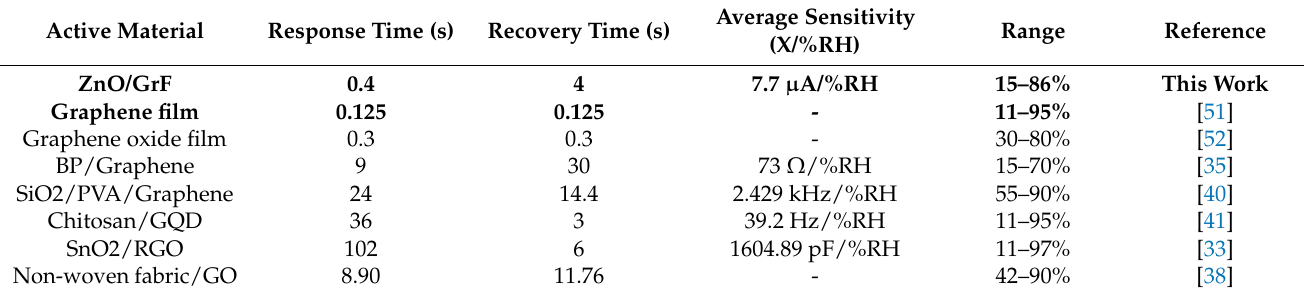
Table 4. General comparison of proposed work with different graphene composite-based humidity